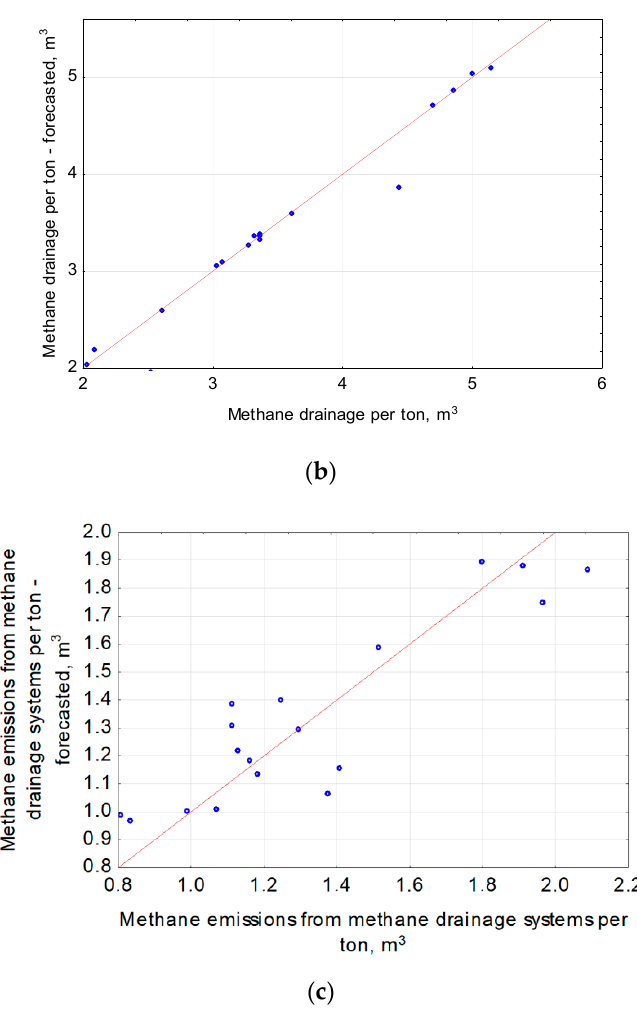
Figure 20. Predicted versus actual values of ventilation methane emissions into the atmosphere ( a ), methane drainage ( b ), and methane emissions from methane drainage systems into the atmosphere ( c ) in relation to one ton of extracted coal.